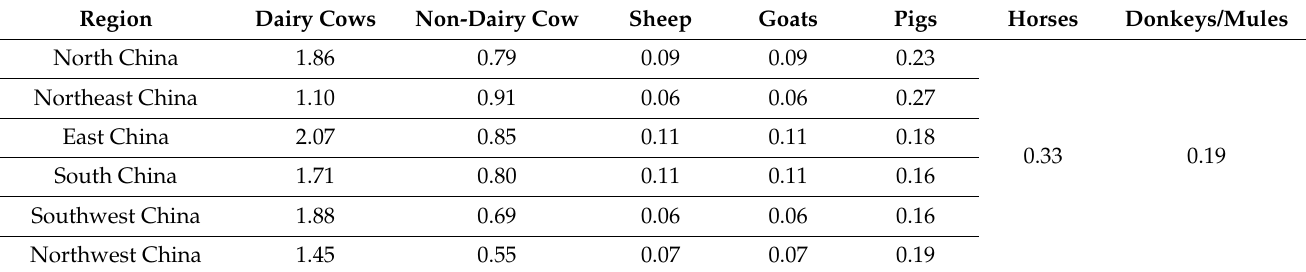
Table 3. Manure-management nitrous oxide emission factors (kg/head/year). Region Dairy Cows Non-Dairy Cow Sheep Goats Pigs Horses